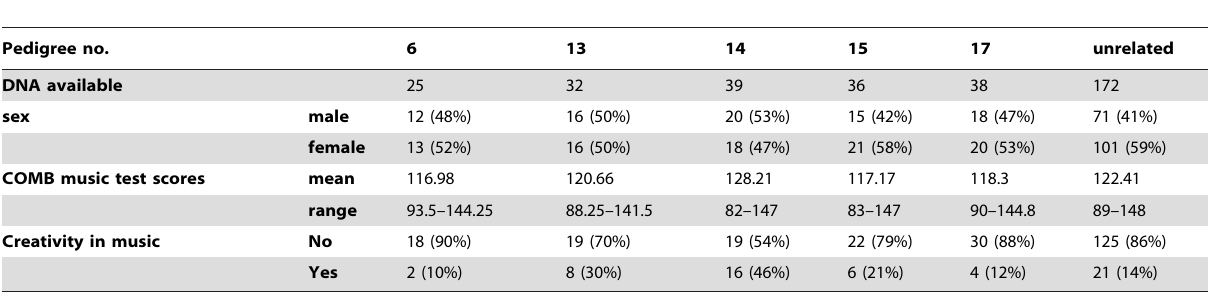
Table 1. Characteristics of each family and the unrelated sample set (N-value).